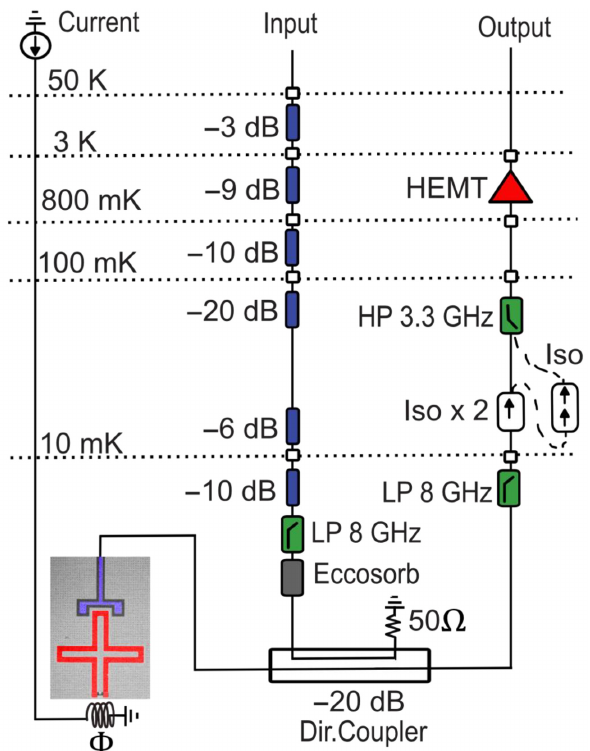
FIG. 5. Experimental setup. Setup inside the dilution refriger- ator. The signal from the input port is attenuated and fed into the waveguide through a low-pass filter (LP), Eccosorb, and a − 20 dB directional coupler. After interacting with the transmon, the signal from the sample goes through the directional coupler again, passes another LP, two isolators (Iso), and a high-pass fil- ter with amplification from a HEMT amplifier (LNA056 from Low Noise Factory). The qubit frequency can be changed by sending a current to the magnetic flux coil to generate an exter- nal magnetic flux (cid:13) through the SQUID. The isolators are from Low Noise Factory where we used two single-junction isolators (LNF-ISC4-8A) when we observed the hot bath. To suppress the noise from the HEMT amplifier, instead of connecting the two isolators to the HP filter, we add a two-junction isolator (LNF- ISISC4-8A) with 40 dB isolation (dashed line). All the isolators are mounted at the 10 mK